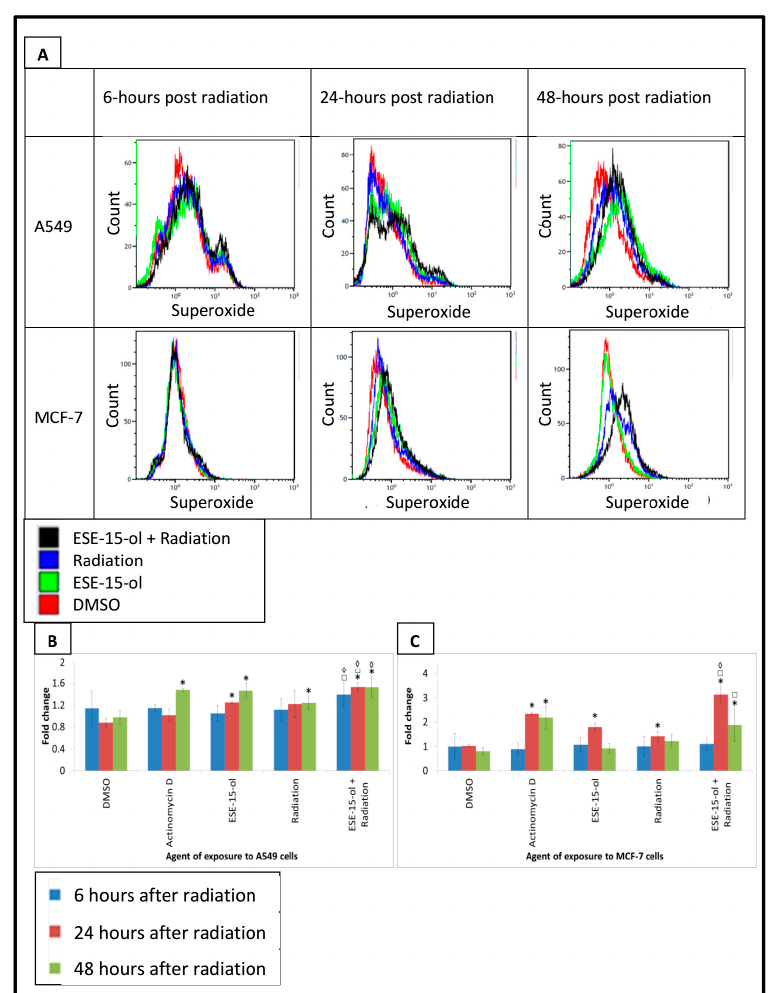
Figure 6. Superoxide detection in A549- and MCF-7 cells exposed to controls and treatment conditions. ( A ) Overlay histograms of A549- and MCF-7 cells exposed to DMSO, ESE-15-ol for 24-h, 6 Gy radiation, and the combination treatment condition. Histograms were obtained by plotting hydroethidine emission (FL3) against cell count. Superoxide levels were measured 6-h, 24-h, and 48-h after radiation. Superoxide levels were significantly increased at 24-h and 48-h in A549- and MCF-7 cells exposed to the different treatment conditions. ( B ) Graphical representations of superoxide detection in A549 cells. ( C ) Graphical representation of superoxide detection in MCF-7 cells. Bars indicate the average of three biological repeats, with standard deviations represented by T-bars. Statistical significance ( p -value < 0.05) represented by * when compared to DMSO, □ when compared to ESE-15-ol treated samples, ♦ when compared to radiation only treated